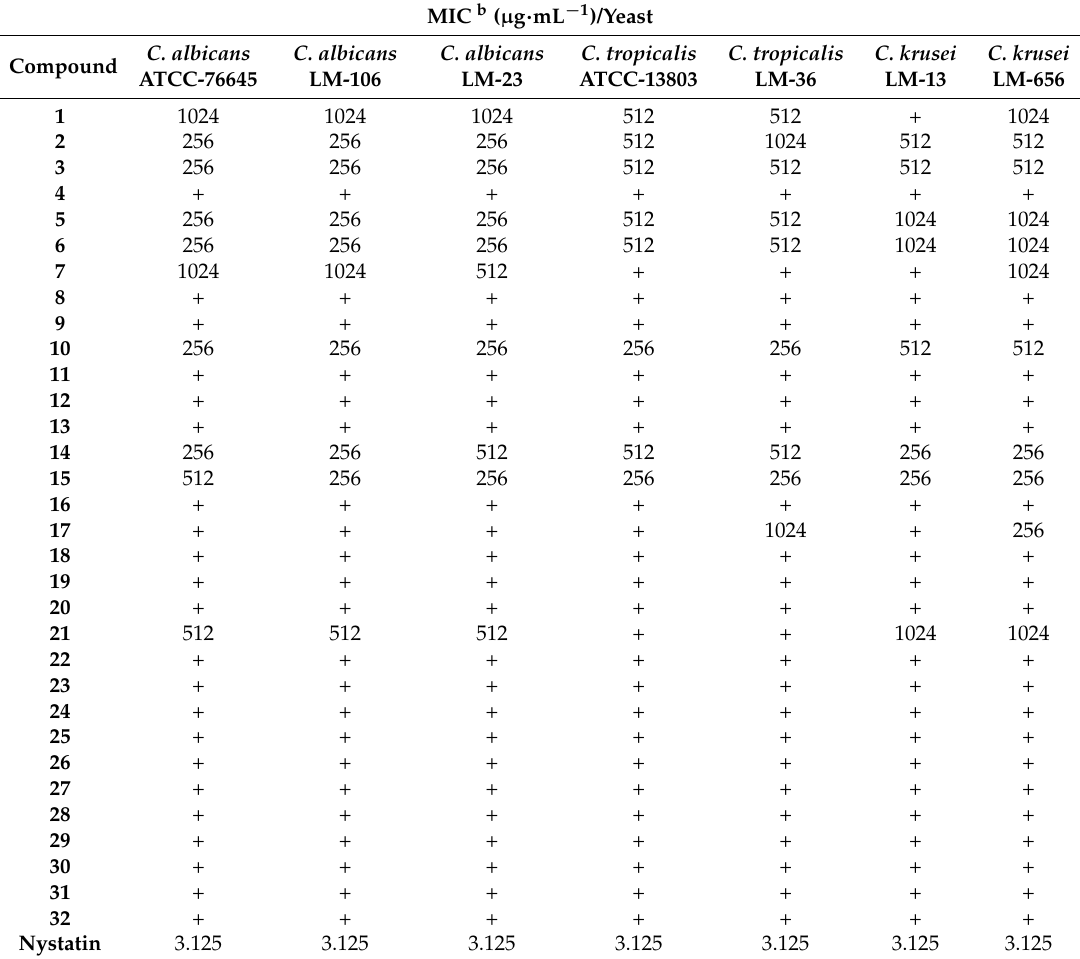
Table 3. Evaluation of MIC ( µ g/mL) of the amides derived from cinnamic acid and benzoic acid in the microdilution broth